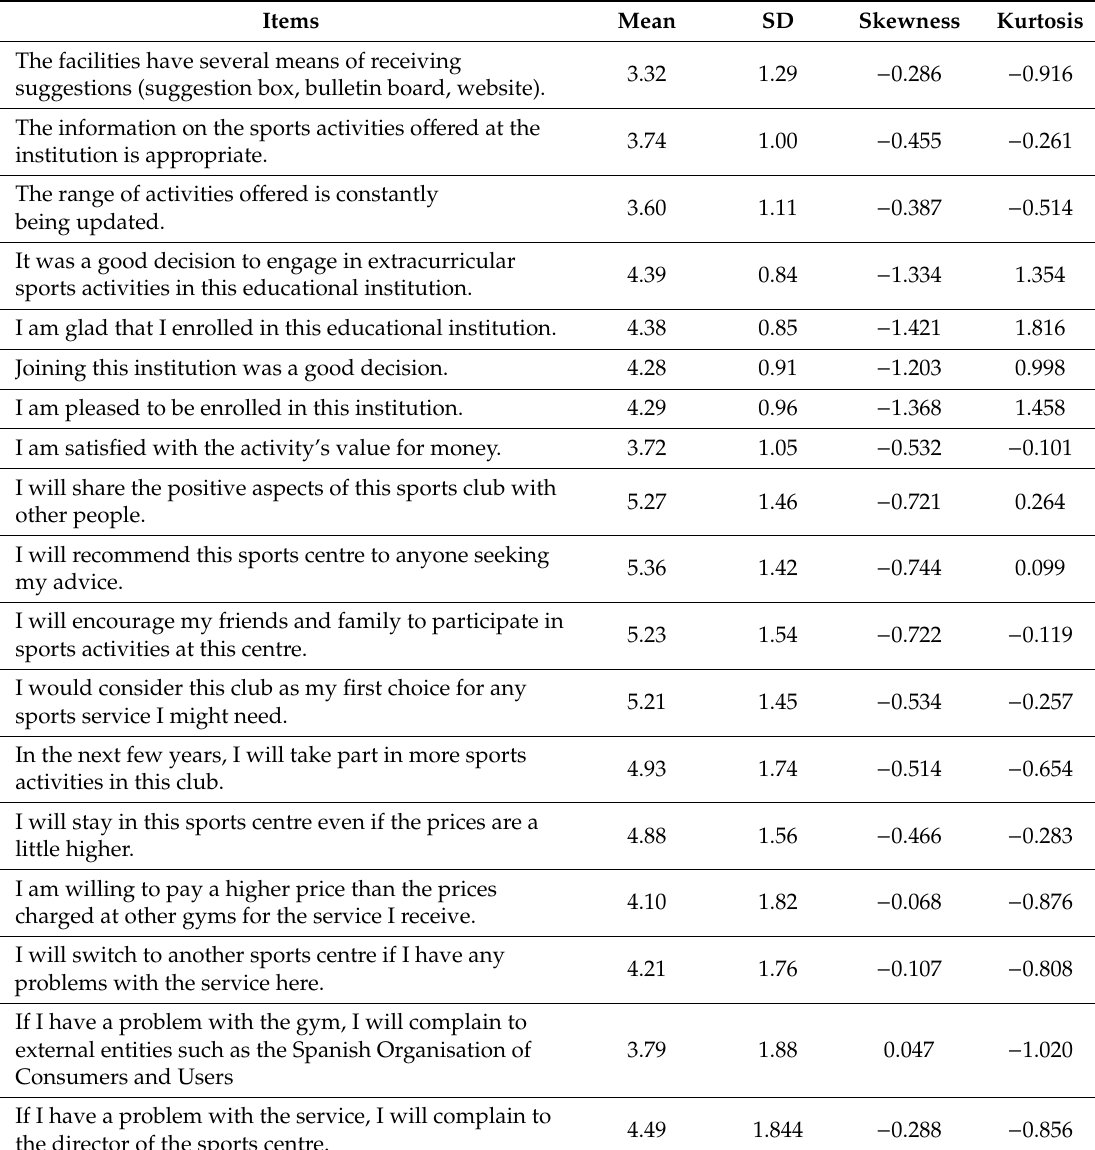
Table 2. Descriptive statistics of the